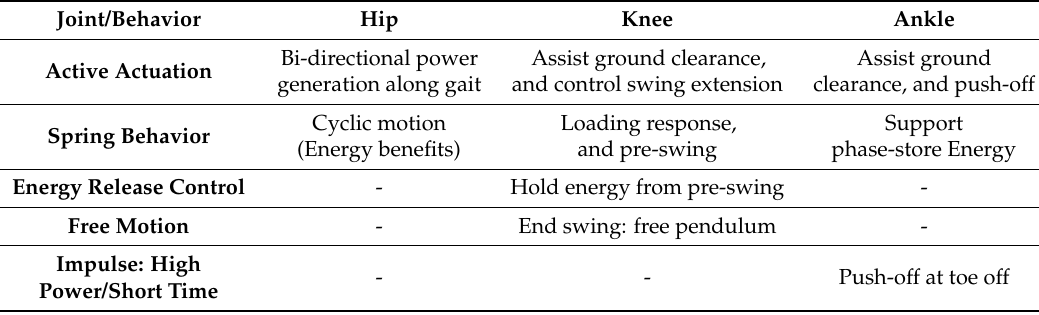
Table 1. Joint characteristics during gait, based on the MTU actuation.